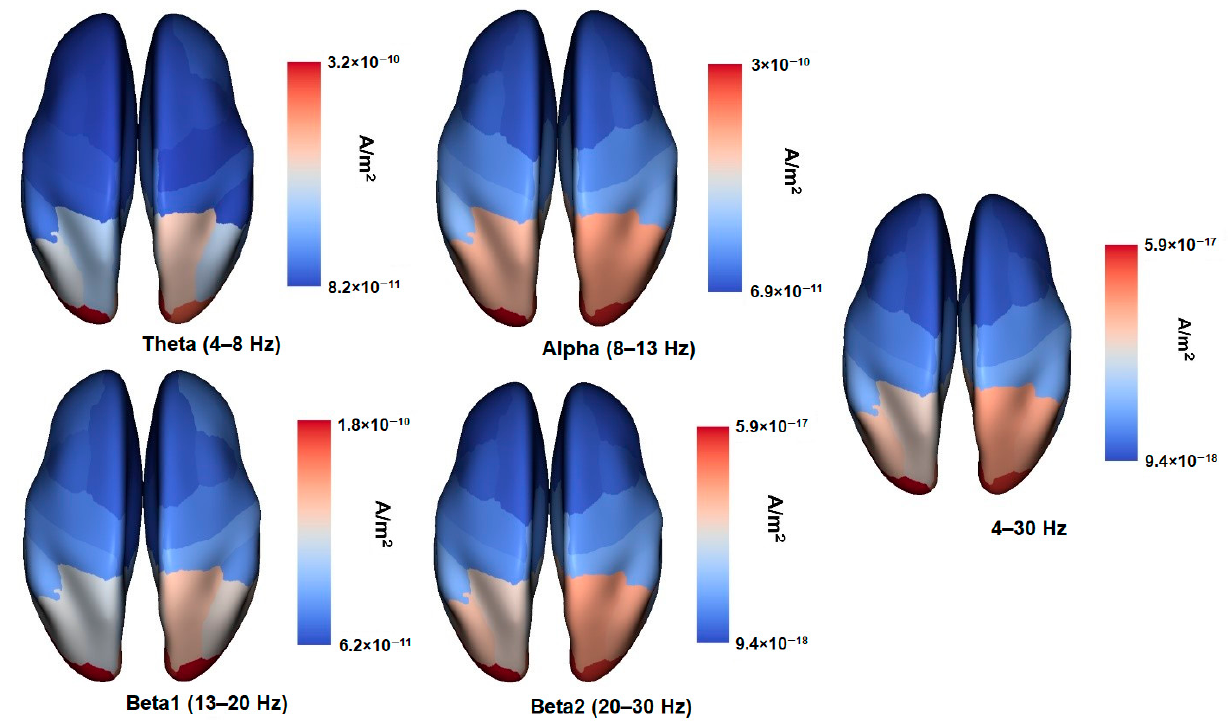
Figure 1. EEG sources density maps for theta (4–8 Hz), alpha (full 8–13 Hz), beta1 (13–20 Hz), beta2 (20–30 Hz), and 4–30 Hz frequency bands. 68 ROIs are reconstructed according to Desikan–Killiany Atlas [50]. Note that the density values are standardized for each frequency band individually.